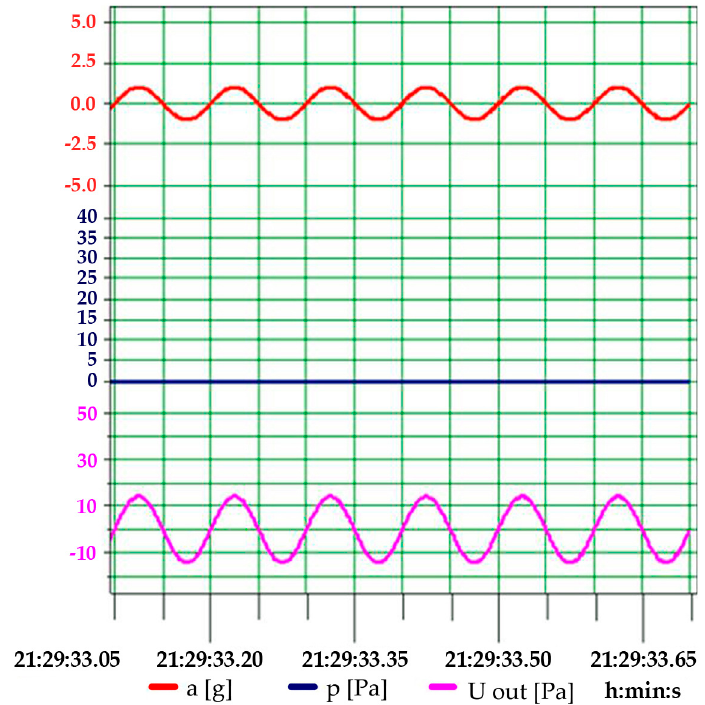
Figure 8. Waveforms of experimental values of acceleration (a), pressure (p), and output signal (U out ) for dynamic acceleration with vibrations and with an amplitude of 1 g and a frequency of f = 10 Hz.